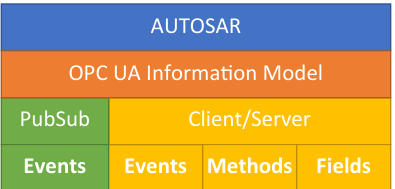
Figure 7. Overview of the combined OPC UA C/S and PubSub binding inside an AUTOSAR service